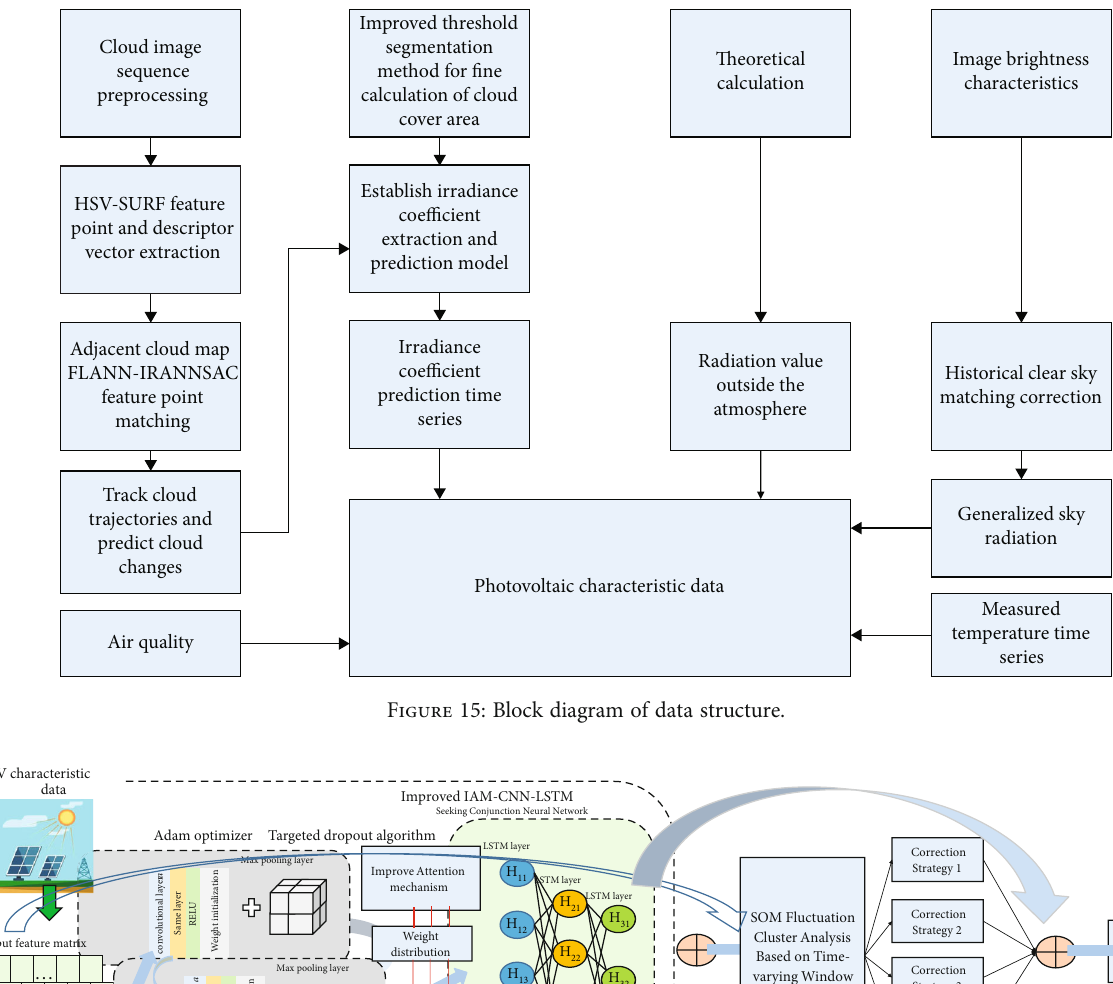
Figure 16: Flowchart of the forecast